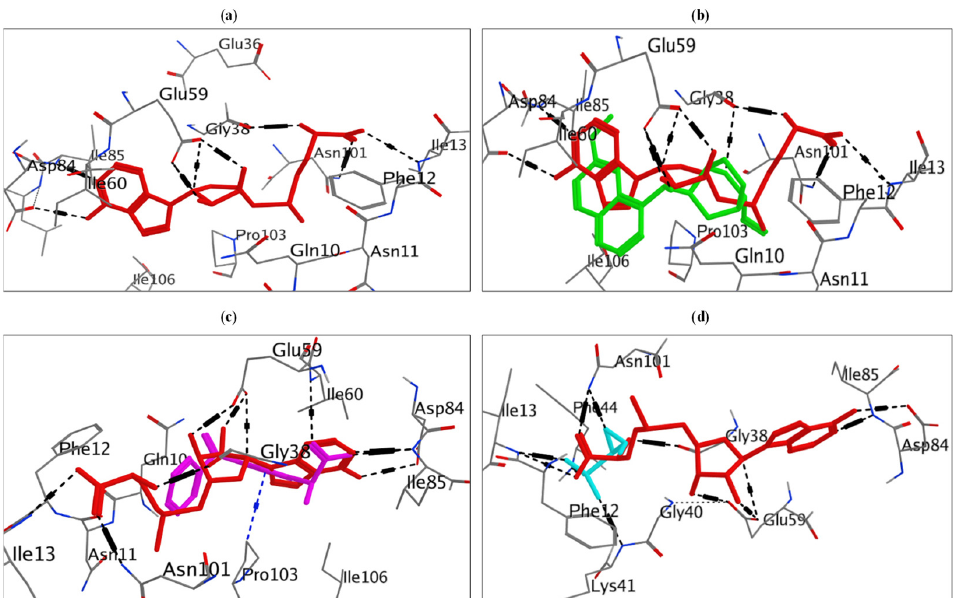
Figure 6. The molecular docking results of SAM, quinine, ketoprofen, and fosfomycin at the SAM- binding site of ErmC’ protein. ( a ) 3D diagram of SAM (red) at SAM-binding site of ErmC’. ( b ) 3D diagram of overlay view of quinine (green) and SAM (red) at SAM-binding site of ErmC’. ( c ) 3D diagram of overlay view of ketoprofen (magenta) and SAM (red) at SAM-binding site of ErmC’. ( d ) 3D diagram of overlay view of fosfomycin (cyan) and SAM (red) at SAM-binding site of ErmC’. For clarity, non-interacting residues were deleted. Hydrogen bonds are shown in black, and arene hydrogen bonds are shown in dark blue (PDB ID: 1QAO).